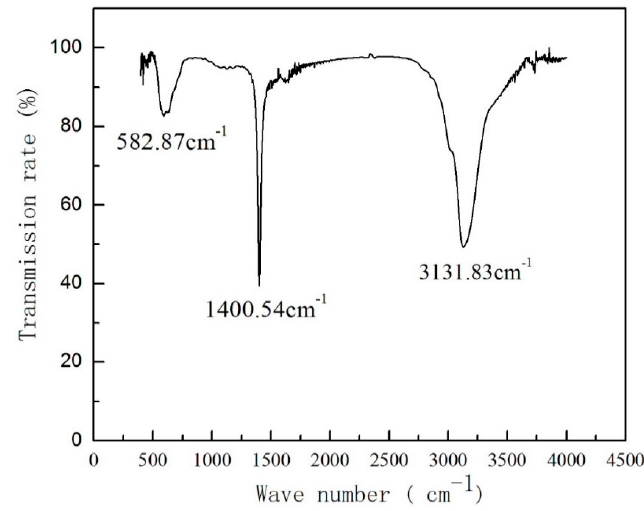
Figure 3. Infrared spectrum of Fe 3 O 4.